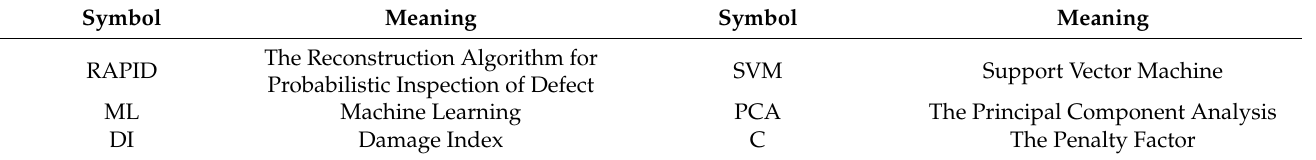
Table 1. The acronyms in the defect imaging